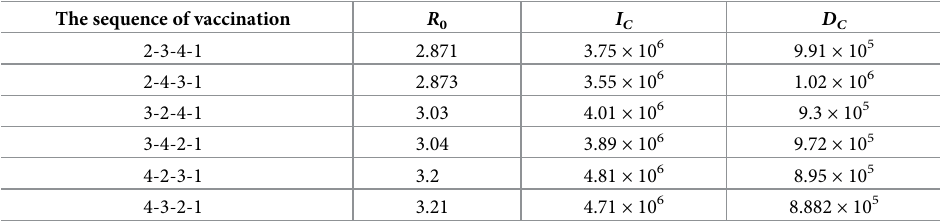
Table 8. R 0 , I C and D C were inoculated in six sequences, Indonesia. The sequence of